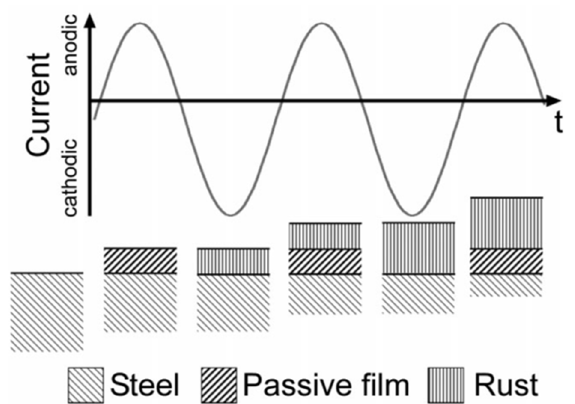
Figure 11. Schematic representation of AC corrosion mechanism according to Büchler et al. [61].